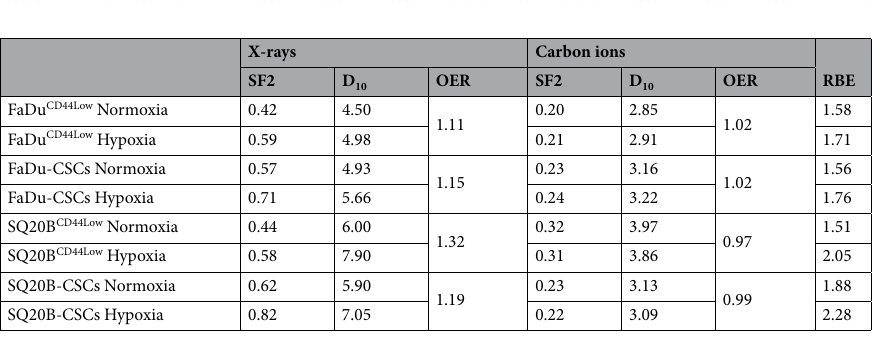
Table 1. Radiobiological parameters. Survival Fractions at 2 Gy (SF2) and D10 values were calculated according the linear-quadratic model in response to photon or carbon ion irradiation under normoxia or chronic hypoxia in the four HNSCC subpopulation studied. The RBE and the OER were also calculated at 10% of cell survival.